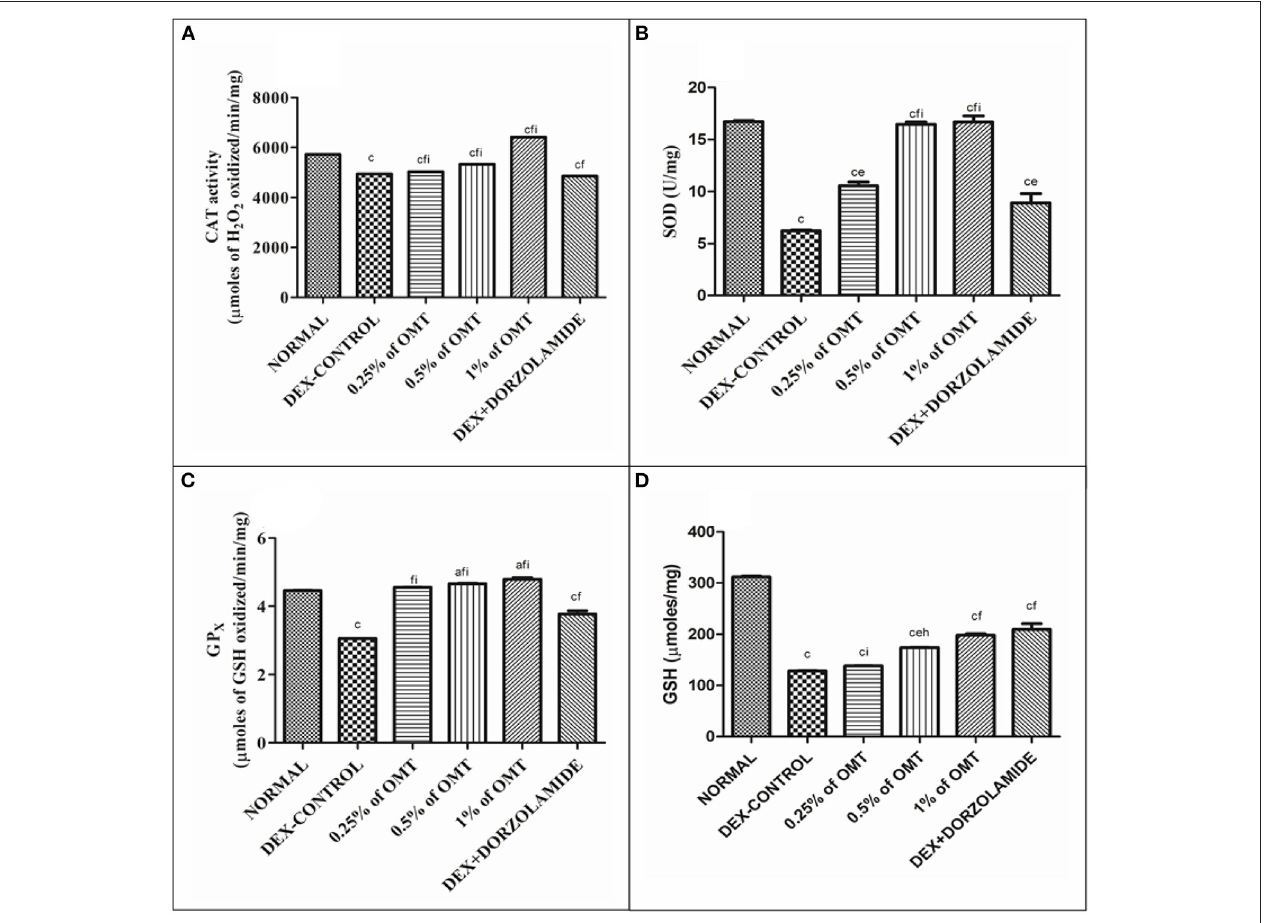
FIGURE 2 | Effects of various treatments of OMT on the levels of antioxidants: (A) CAT, (B) SOD, (C) GPX, and (D) GSH. Values are expressed as mean ± SEM (n = 6). Data were analyzed by one-way ANOVA and are expressed as ap < 0.05, bp < 0.01, cp < 0.001 when compared to normal group, dp < 0.05, ep < 0.01, fp < 0.001 when compared to DEX-induced glaucoma control group, and gp < 0.05, hp < 0.01, and ip < 0.001 when compared to standard group, respectively. Normal: 100 µ l of distilled water; control: 0.1 ml of 0.1% DEX solution; treatment 1: 50 µ l of 0.25% OMT solution; treatment 2: 50 µ l of 0.5% OMT solution; treatment 3: 50 µ l of 1% OMT solution; standard: 100 µ l of 1% of dorzolamide